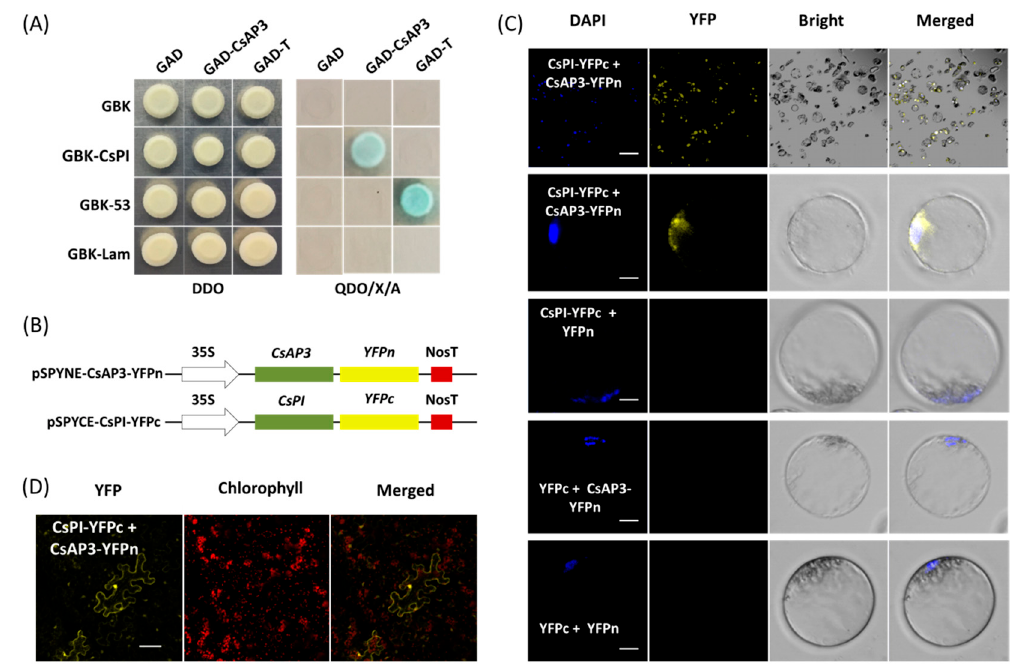
Figure 4. Protein–protein interaction studies using the PTES. ( A ) Yeast two-hybrid assay (Y2H) of proteins encoded by CsPI and CsAP3 . ( B ) Vectors used for bimolecular fluorescence complementation (BiFC) assays were obtained by cloning the full-length CDSs of CsAP3 and CsPI into the vectors pSPYNE-35S and pSPYCE-35S, respectively. ( C ) Fusion proteins CsAP3-YFPn and CsPI-YFPc were co-expressed in Cymbidium protoplasts and yellow fluorescent protein (YFP) signals were detected in nuclei where the DAPI signal presented, while negative controls did not produce any BiFC fluorescence; ( D ) BiFC assays were also carried out in N. benthamiana leaves and strong YFP signals were observed in the protoplasts, especially in the nuclei. Bar = 10 μ m.